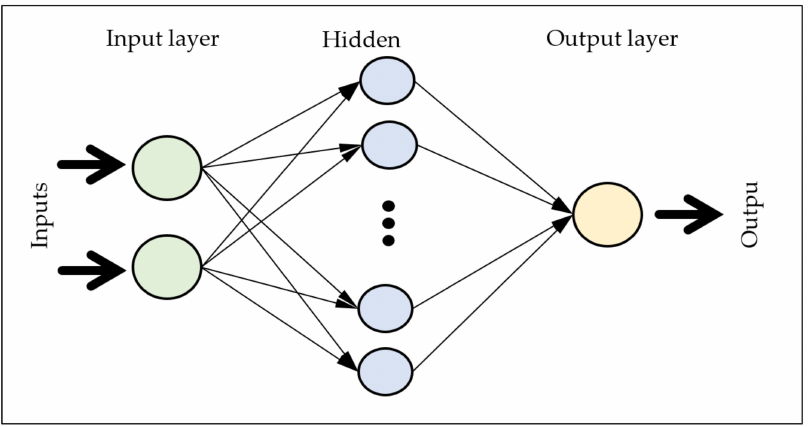
Figure 4. Shallow neural